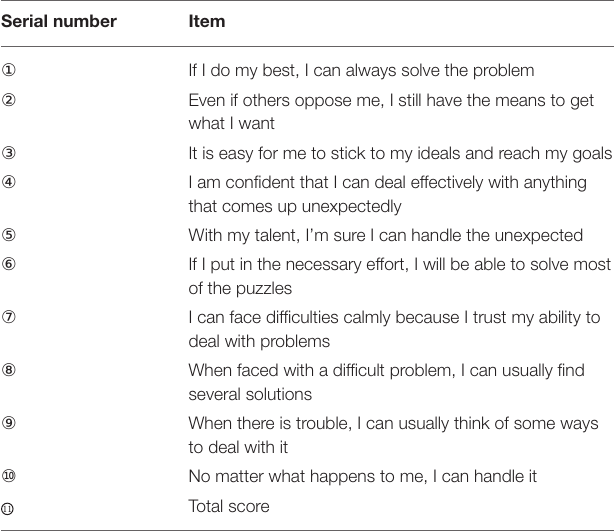
TABLE 4 | GSES scale of new